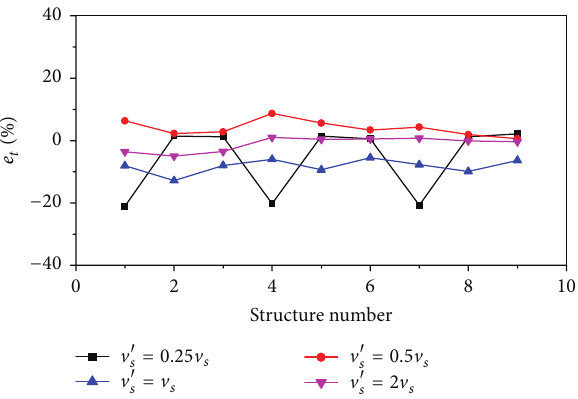
Figure 29: Interaction among structures in terms of influence coefficient 𝑒 with respect to the subsoil shear wave